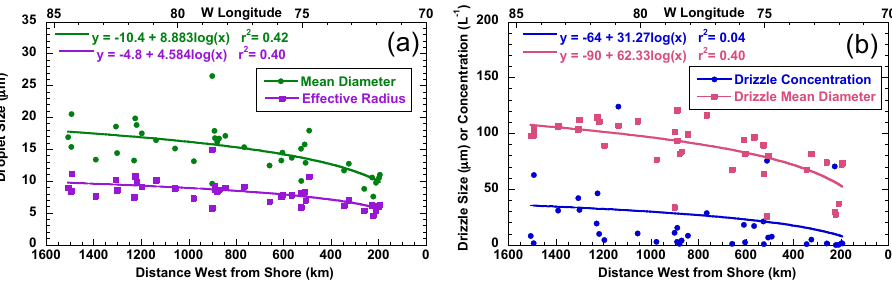
Fig. 2. (a) Mean cloud droplet mean diameter and effective radius from the CDP vs. distance west from shore. Median standard deviation along the flight legs was 2.2 for the mean diameter and 1.3 for effective radius. Sizing uncertainty varies with droplet size and concentration but is estimated to be less than 15% for most cases (Lance et al., 2010; King et al., 2013). (b) Drizzle drop mean size and number concen- tration as a function of distance from shore. Mean sizes below the effective detection limit of the probe (60 µm) are due to inclusion of zero values when no drizzle was present in cloud. Median standard deviation along the flight legs was 28 for the drizzle mean diameter and 5.4 for concentration. Uncertainty of the 2D-C parameters is complex and depends on many factors, including droplet size; for more information see Baumgardner and Korolev (1997) and Korolev